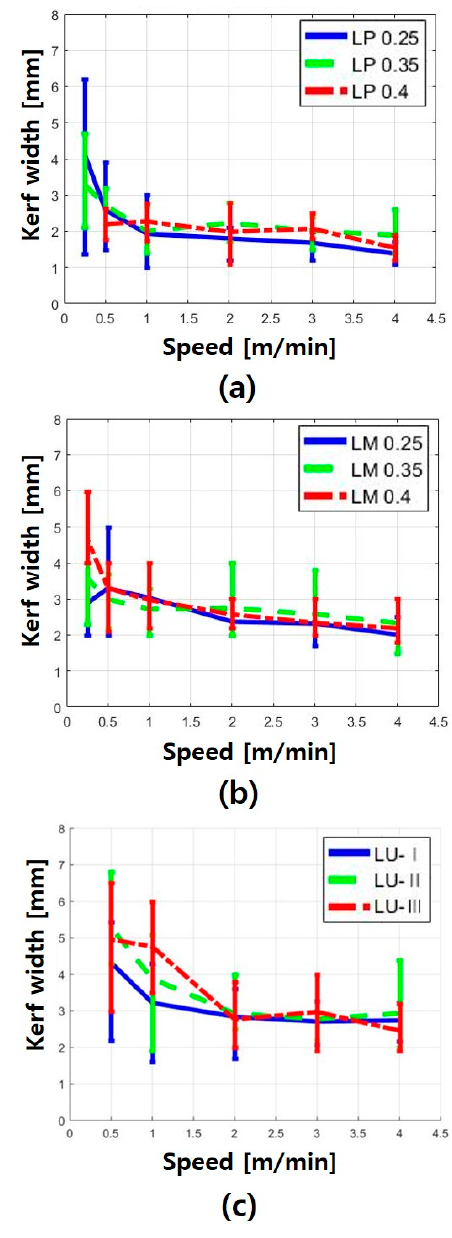
Figure 4. Minimum, maximum, and average values of kerf width on ( a ) LP, ( b ) LM, and ( c ) LU.